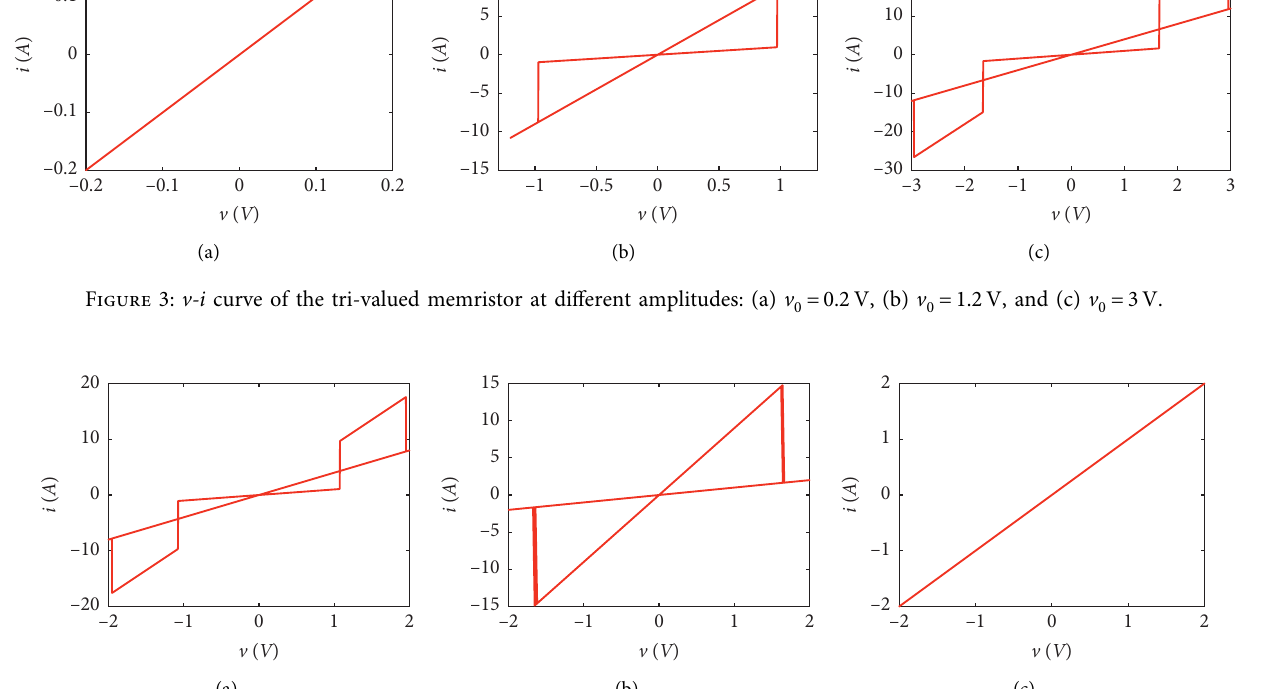
Figure 4: v-i curve of the tri-valued memristor at different frequencies: (a) f � 0.1Hz, (b) f � 1Hz, and (c) f � 1.5